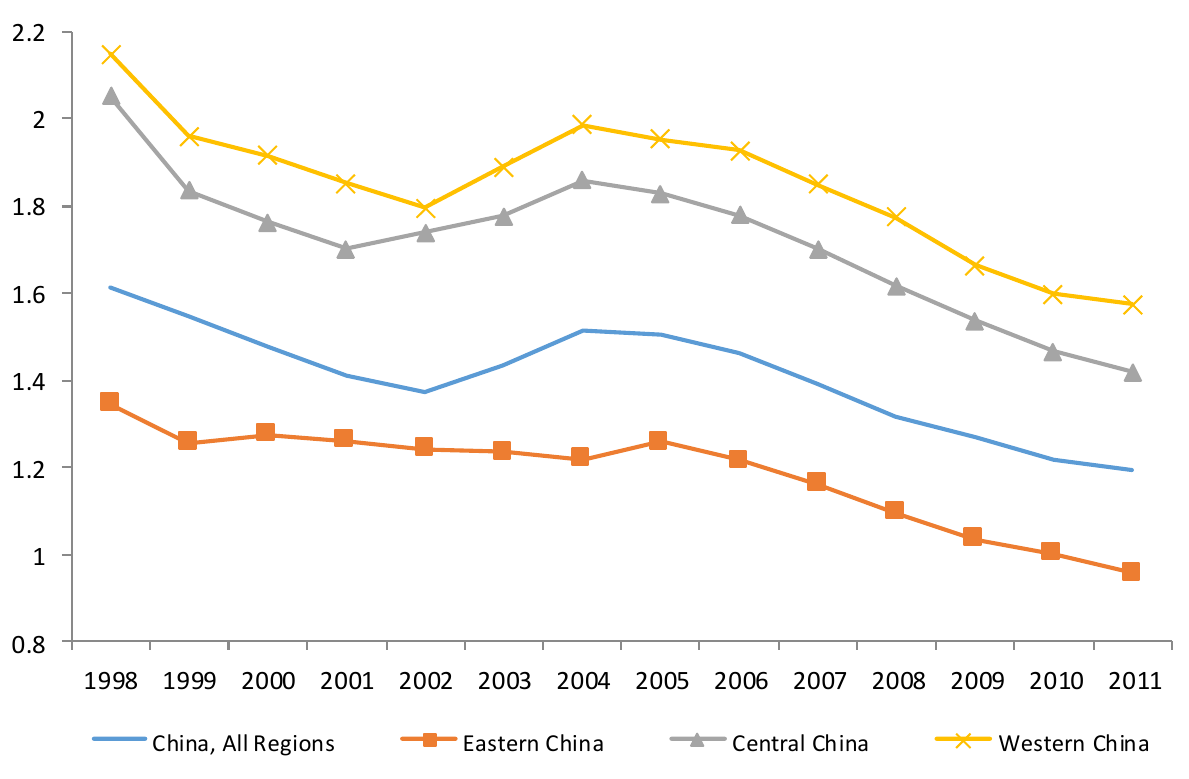
Figure 2. Energy intensity in China. Source: China Energy Yearbook and China Statistical Yearbook